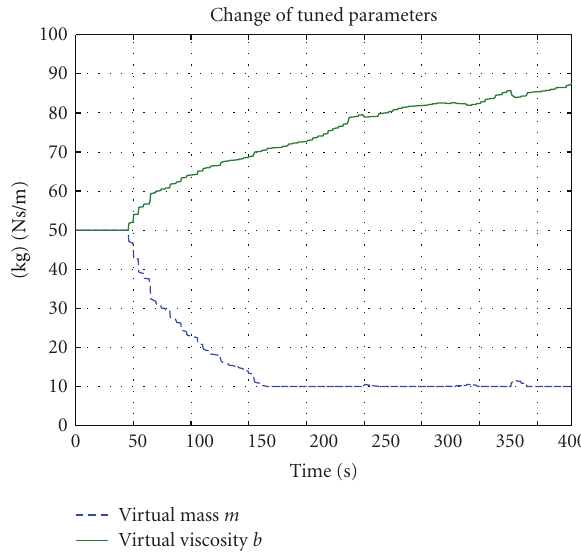
Figure 13: Evolution of tuned parameters.